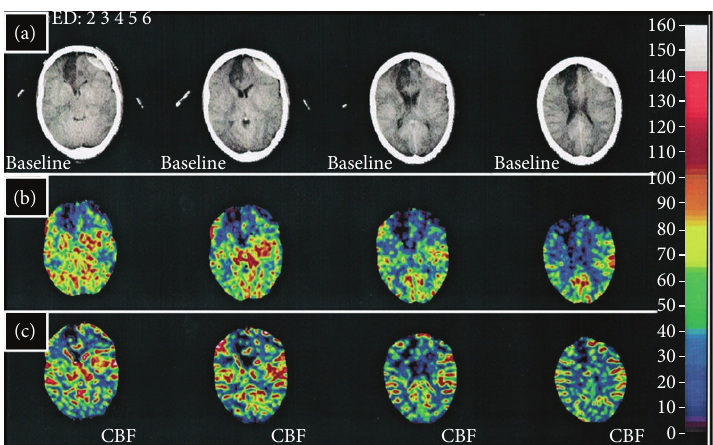
F 9: Xenon-Enhanced CT. Baseline CT images (row (a)) indicate a right ACA infarct following aneurysmal rupture of the right ACA. A �rst Xe/CT study performed with induced hypertension (row (b)) demonstrated a region of ischemia (reduced CBF) in the le frontal region consistent with vasospasm. A second Xe/CT study performed aer the withdrawal of pressors (row (c)) did not demonstrate this same region of ischemia. e �gure is adapted from [1].